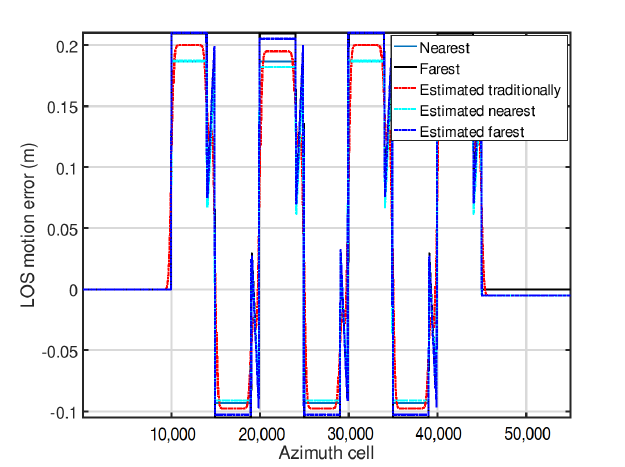
Figure 12. Comparison results of signal s 8 with the proposed range-variant/traditional RRAC. ( a ) The result for point B with traditional RRAC. ( b ) Point B with the proposed RvRRAC. ( c ) Point C with traditional RRAC. ( d ) Point C focused with RvRRAC.